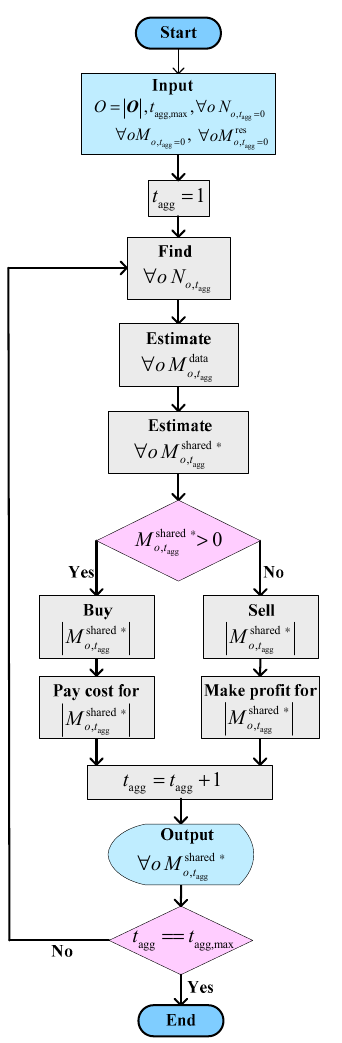
Figure 3. A flowchart of the proposed DESA method.